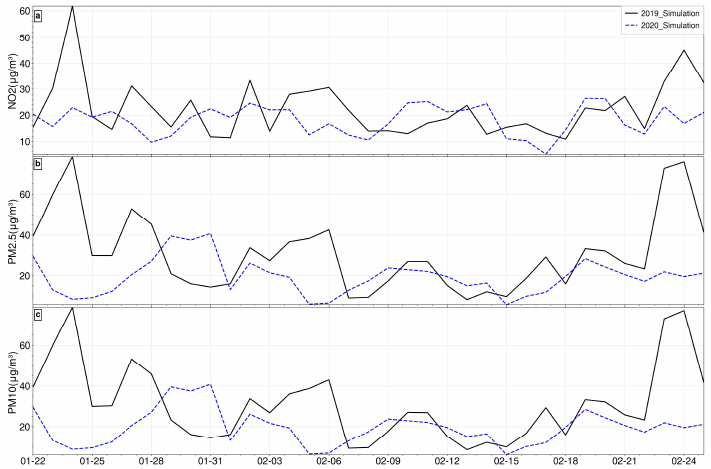
Figure 8. Daily average concentrations ( μ g/m (cid:2871) ) of industrial emissions of NO 2 ( a ), PM 2.5 ( b ), and PM 10 ( c ) in Nanjing during the NP and LP. PM 10 ( c ) in Nanjing during the NP and